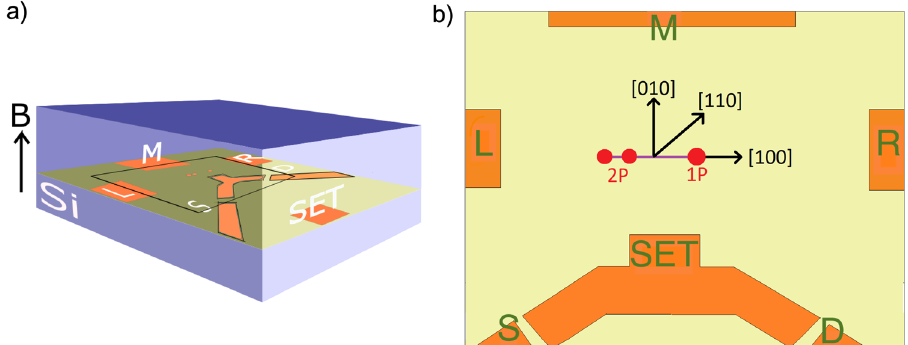
Fig. 2 Schematic of a 2P:1P EDSR qubit architecture, illustrating the way our qubit design can be adapted to atomic scale lithographic techniques using in-plane gates. a The Si matrix (blue box) is shown, with the highlighted green plane containing the physical 2 P : 1 P qubit along the [100] direction, as emphasised on the right. A schematic of the STM image of the proposed qubit device is presented following ref. 20 . ; M middle gate, L left gate, R right gate, S source, D drain, and SET signifying single electron transistor gate. b A qubit geometry with both dots 2P-1P aligned along [100] crystallographic direction. The left, right and middle gates mediate the charge distribution between the dots, hence control single qubit